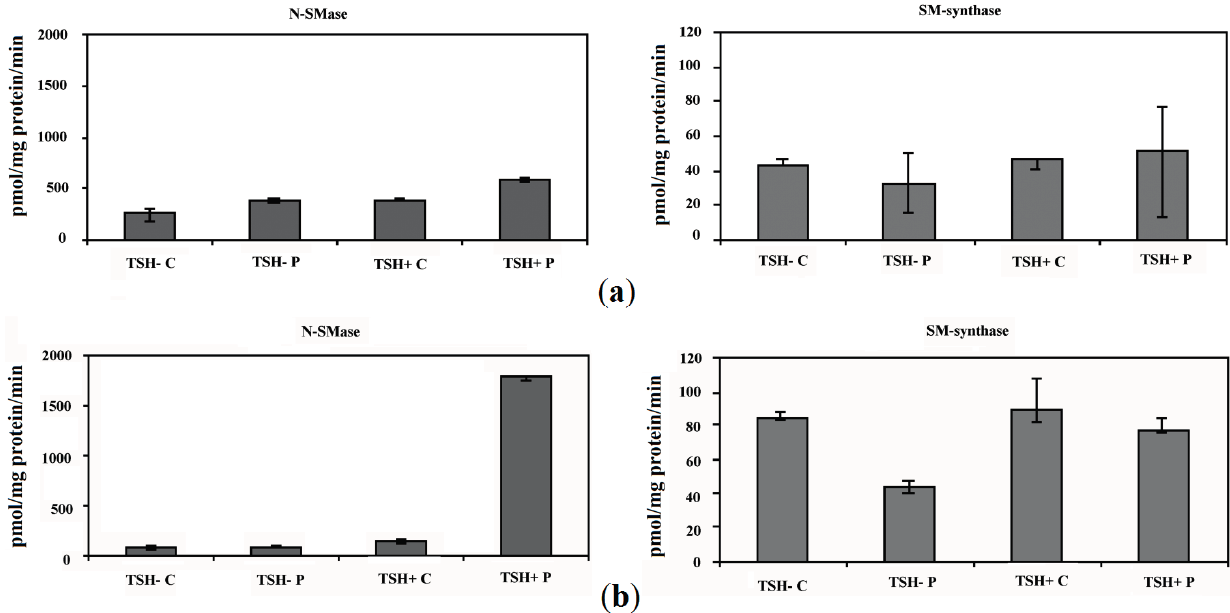
Figure 2. Effect of proton irradiation on neutral-sphingomyelinase ( N -SMase) and sphingomyelin-synthase (SM-synthase) activity in: ( a ) nuclei-free lysates (NFL) and ( b ) purified nuclei (N). C, control; P, proton. Data are expressed as pmol/mg protein/min and represent the mean and range of three separated